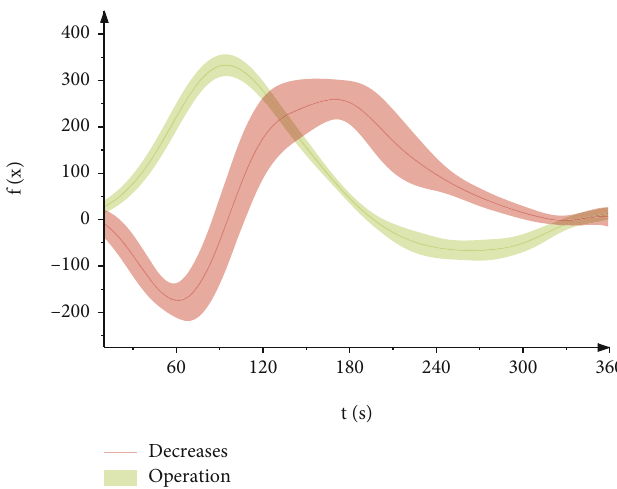
Figure 1: Plot of di ff usion function of the Perona-Malik